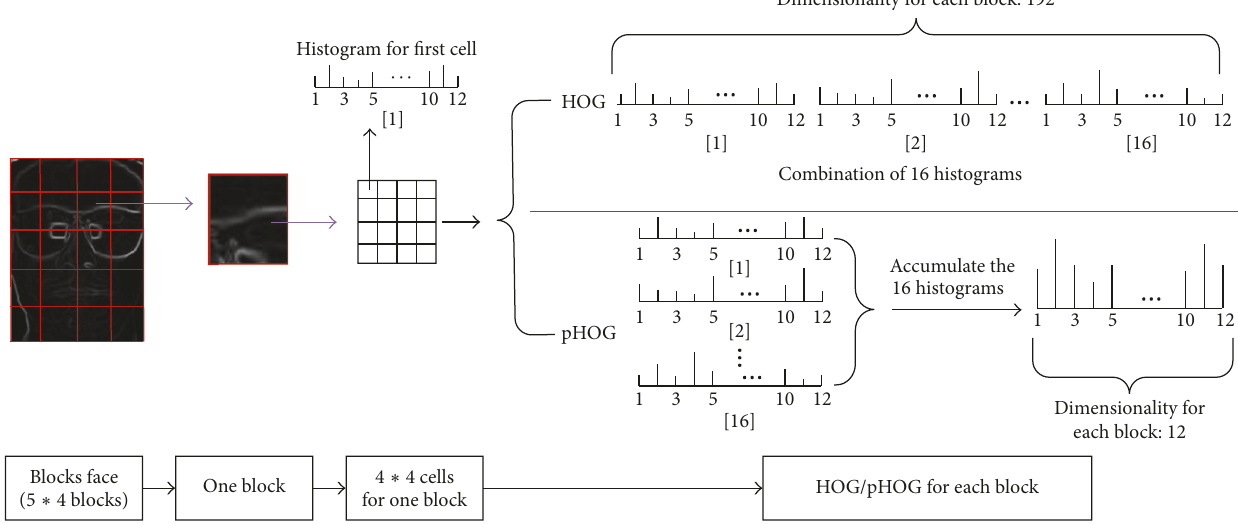
Figure 4: The main process of extracting the pHOG